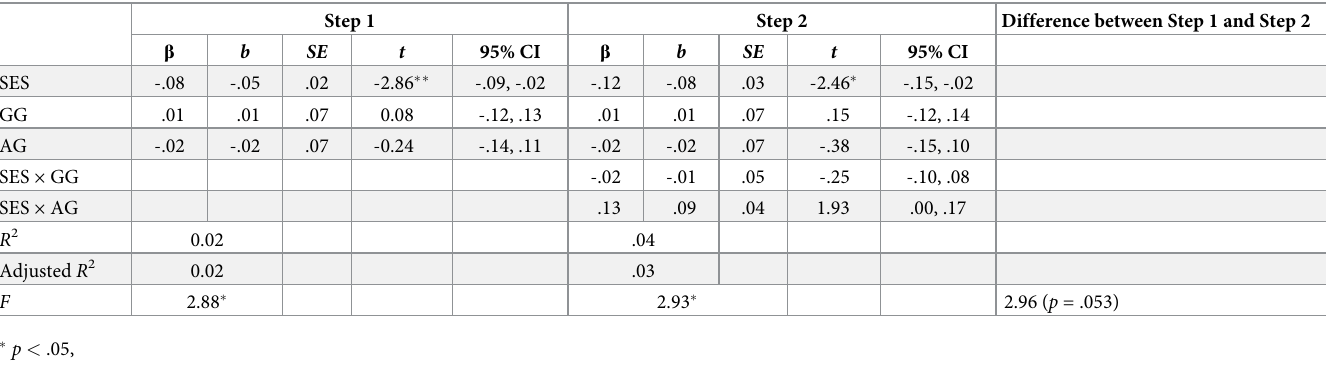
Table 7. Hierarchical regression results for maladaptive